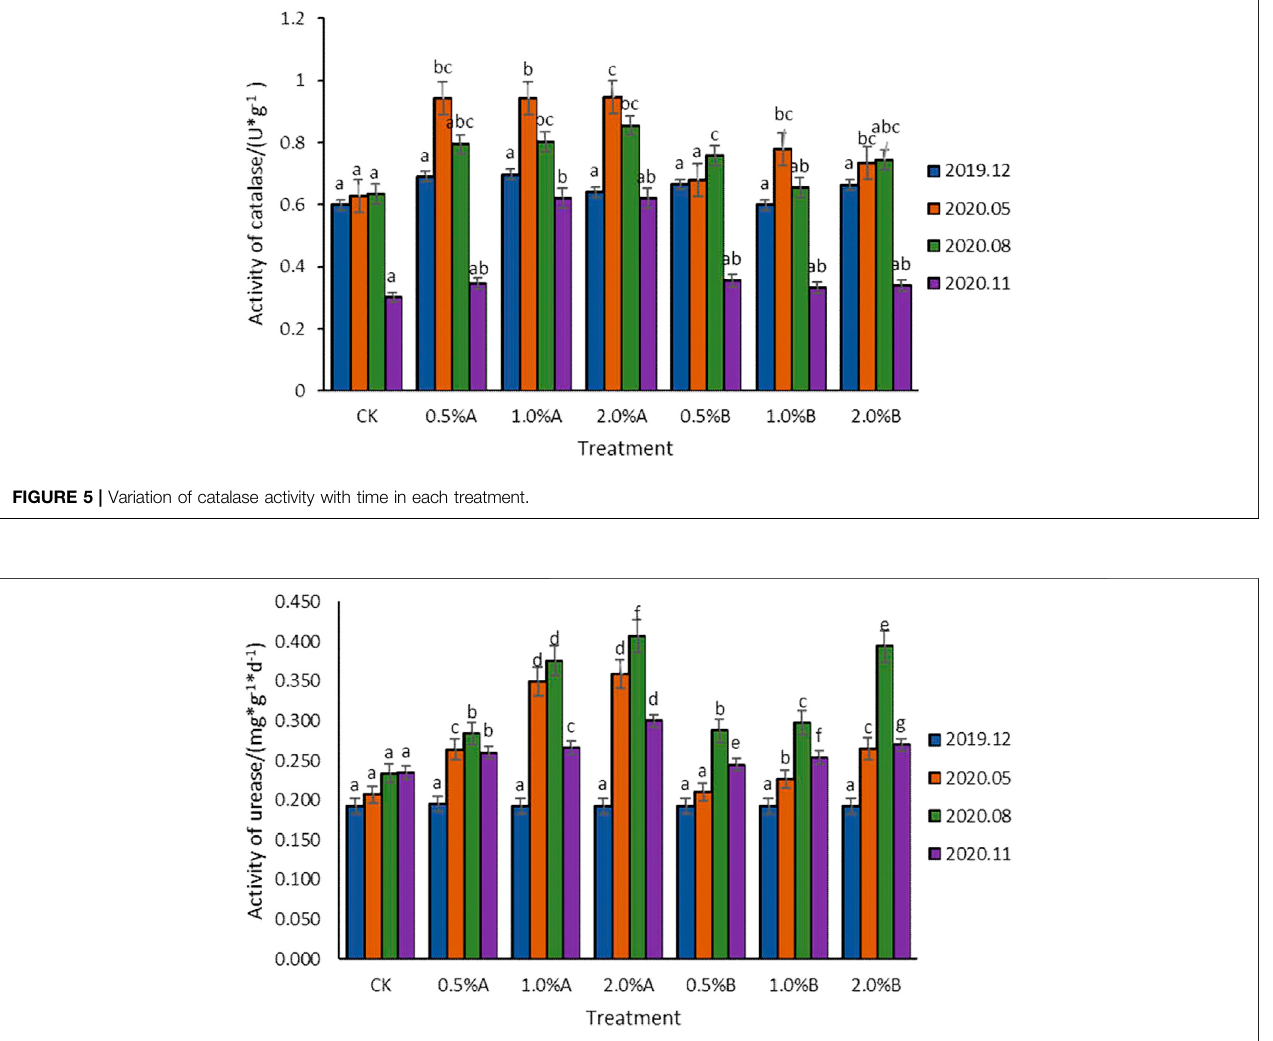
FIGURE 6 | Variation of urease activity with time in each